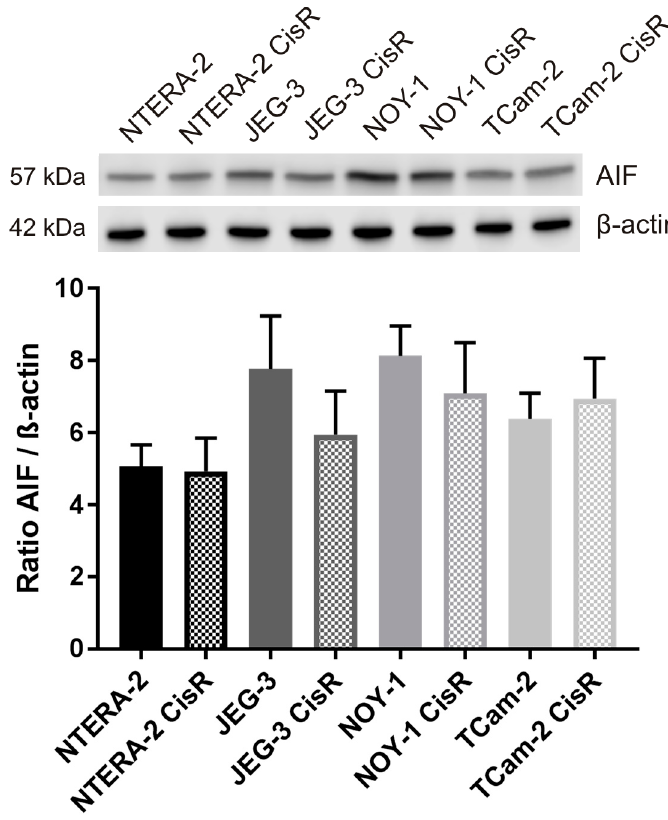
Figure 2. AIF expression in different GCTs cell lines on protein level by Western blot.